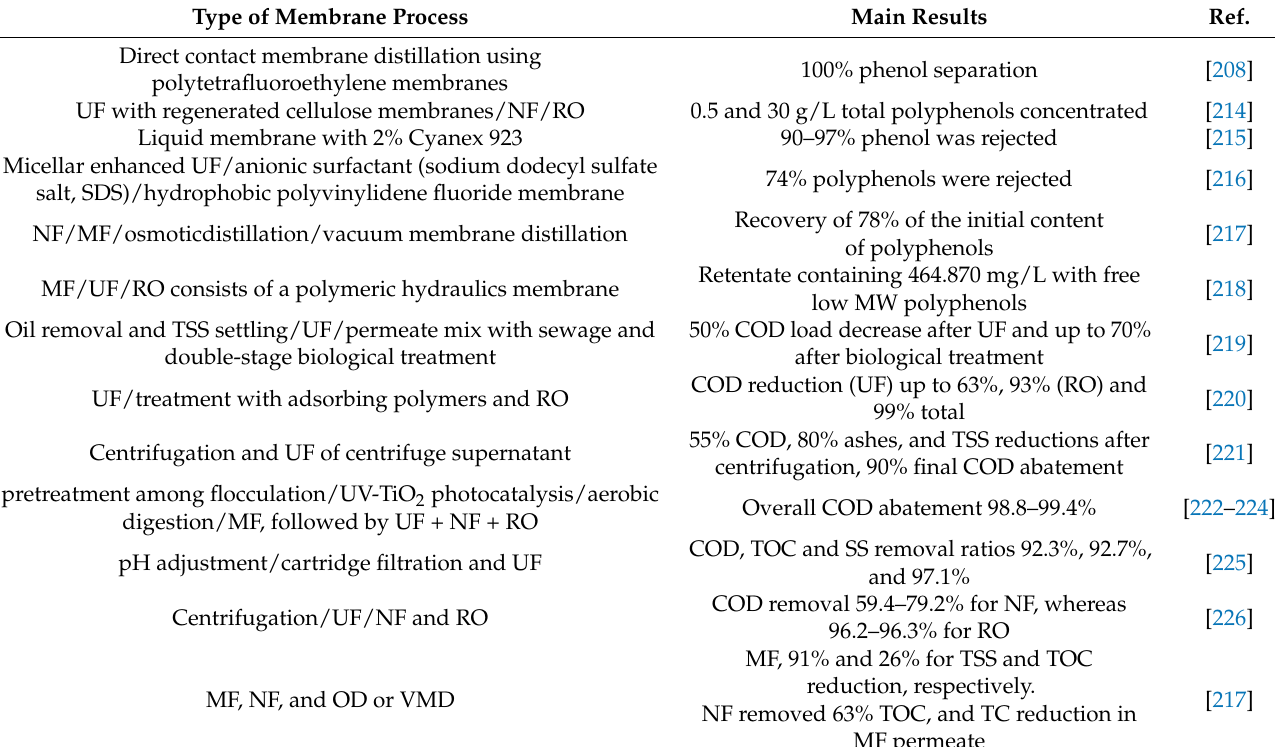
Table 11. Membrane technology applied to recover OMW valuable materials. Type of Membrane Process Ref.